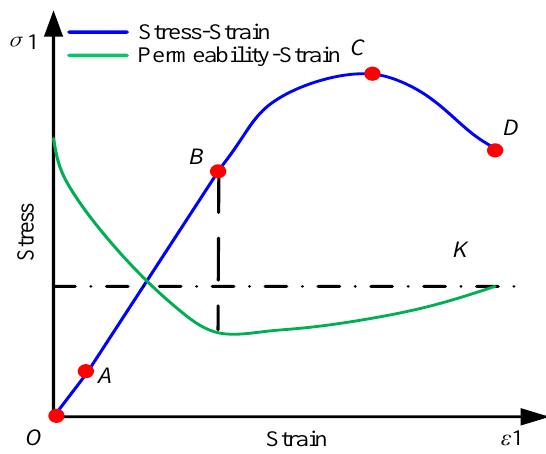
Figure 6. Trend diagram of permeability change law during stress–strain process.